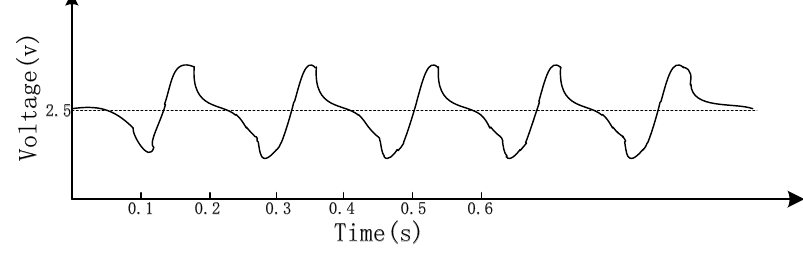
Figure 4. Sensor waveform by electrical